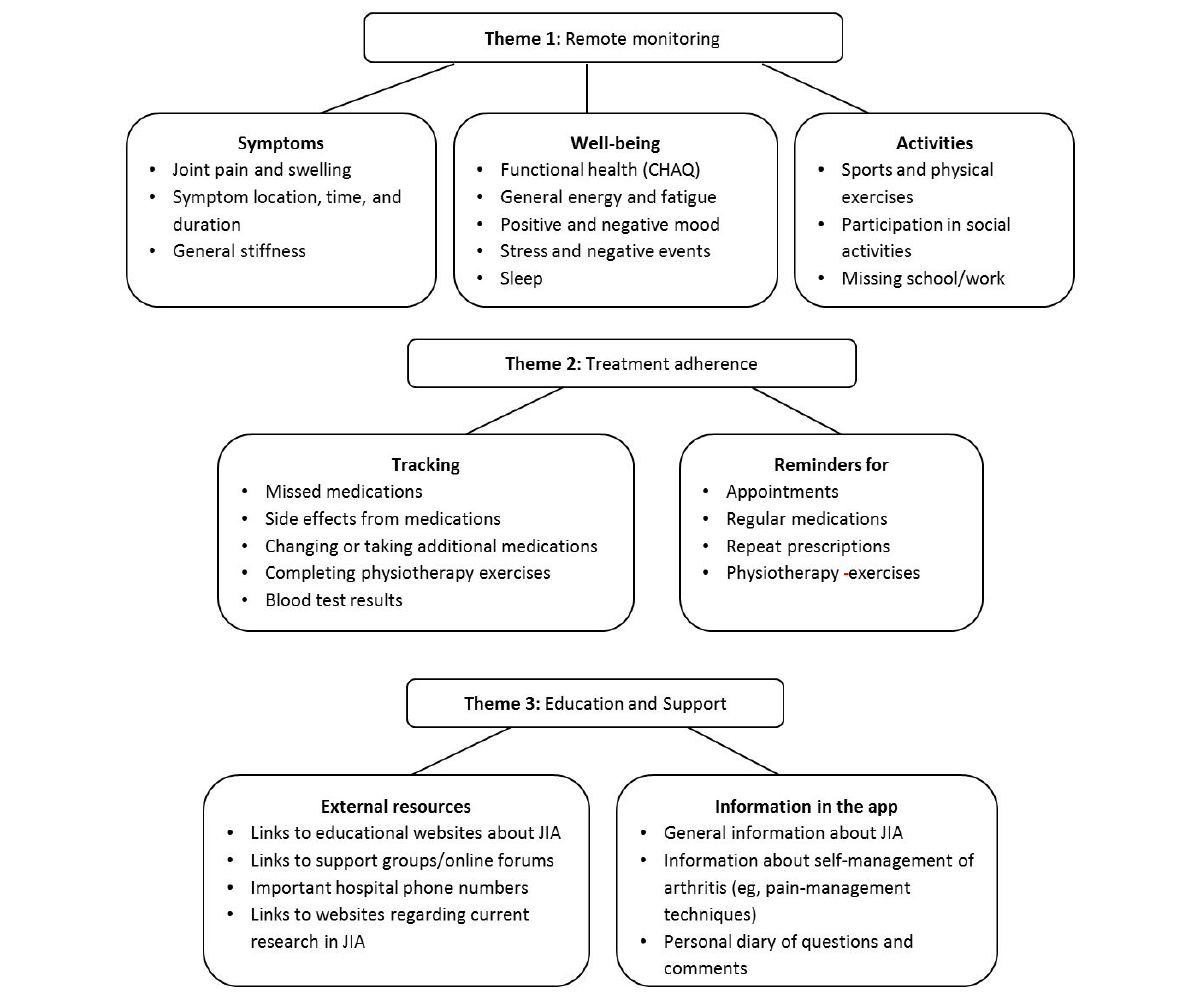
Figure 2. Results of content analysis of transcripts from focus groups for phase